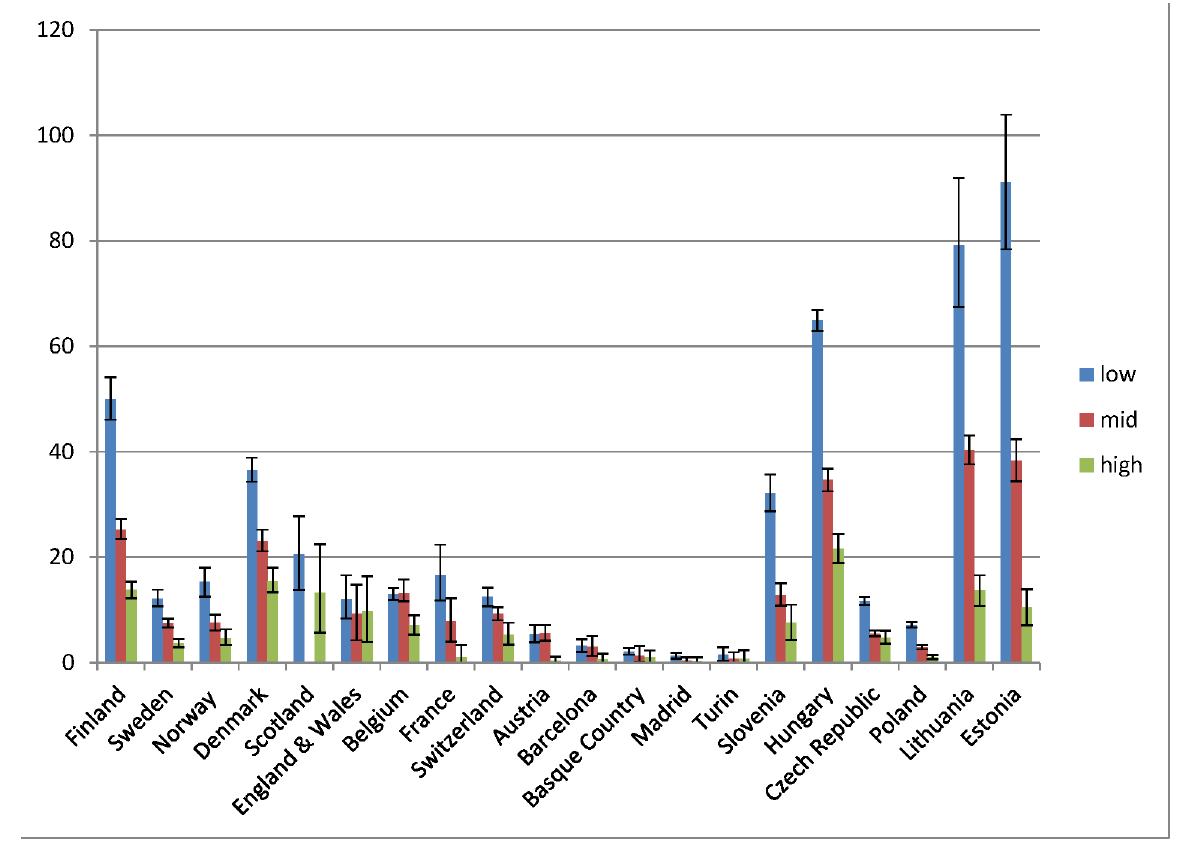
Fig 2. Latest observed mortality from alcohol-related causes among women aged 35 – 79 y, by population and level of education. The y- axis shows alcohol-related mortality, with 95% CIs, in deaths per 100,000 person-years. Among Scottish women in the middle education group, the number of deaths was smaller than ten, and because of confidentiality regulations, data could not be supplied for this